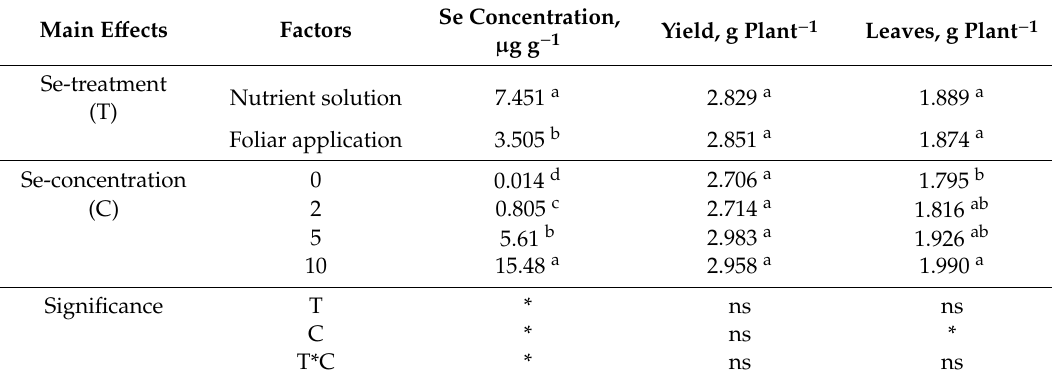
Table A1. Results of 2-factorial ANOVA for Se concentration in leaves and